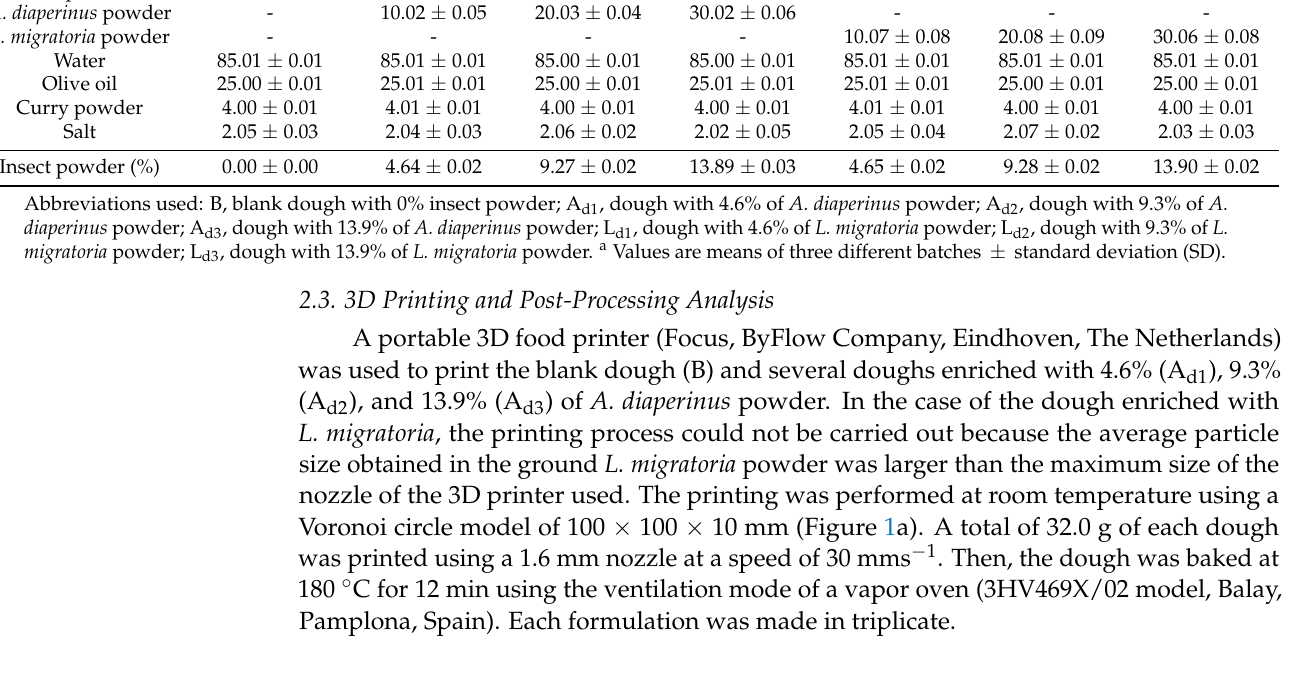
Table 1. Insect powder percentage and measured weight of each ingredient for different formulations. Ingredients